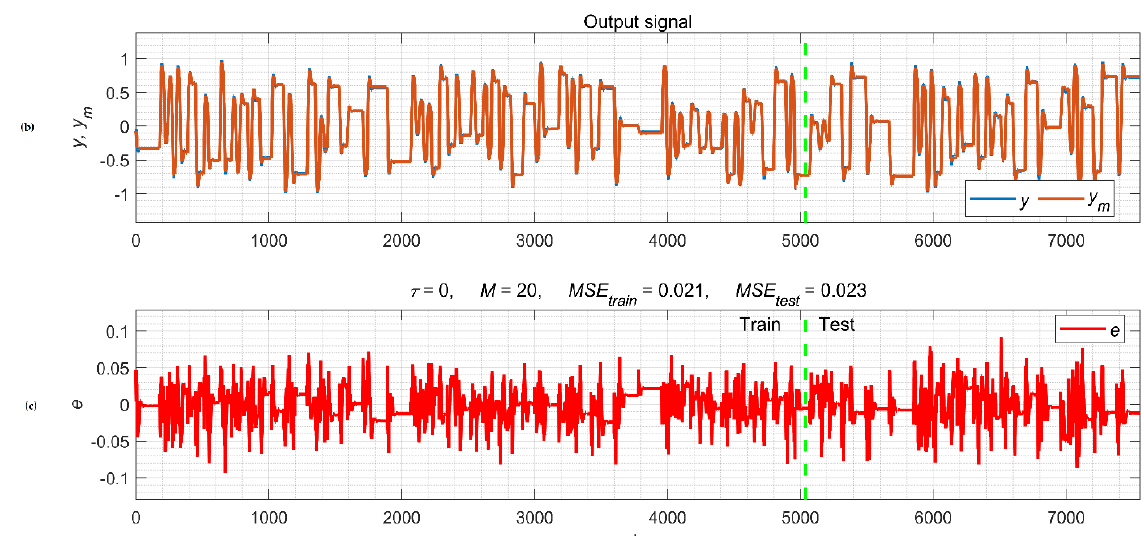
Figure 8. Comparison between desired outputs y and predicted outputs y m for the Hammerstein nonlinear dynamic test process obtained in the training session: ( a ) amplitude modulated pseudo random binary signal (APRBS); ( b ) model output signal y m and the output y of the process; ( c ) model error e . A dotted green line separates the training area and the testing area.